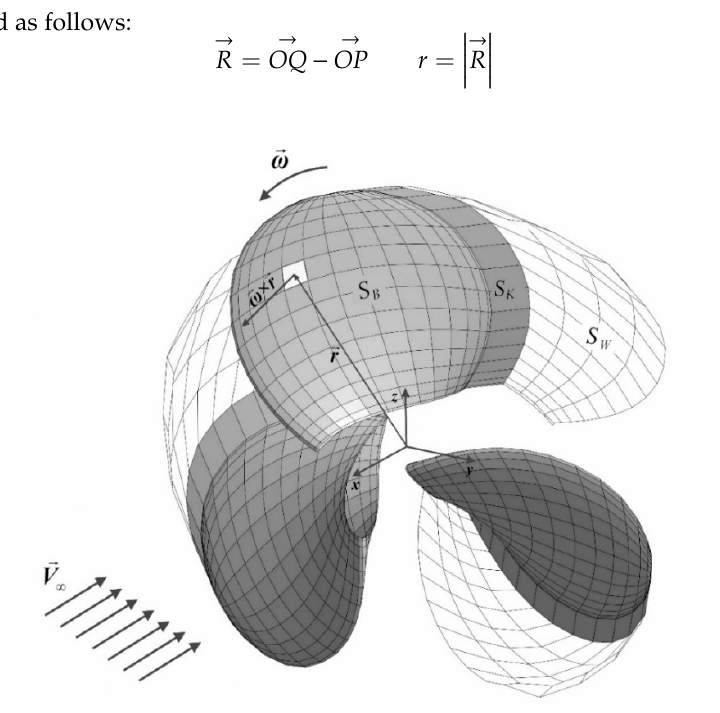
Figure 1. Body surface, Kutta strip and wake surface.